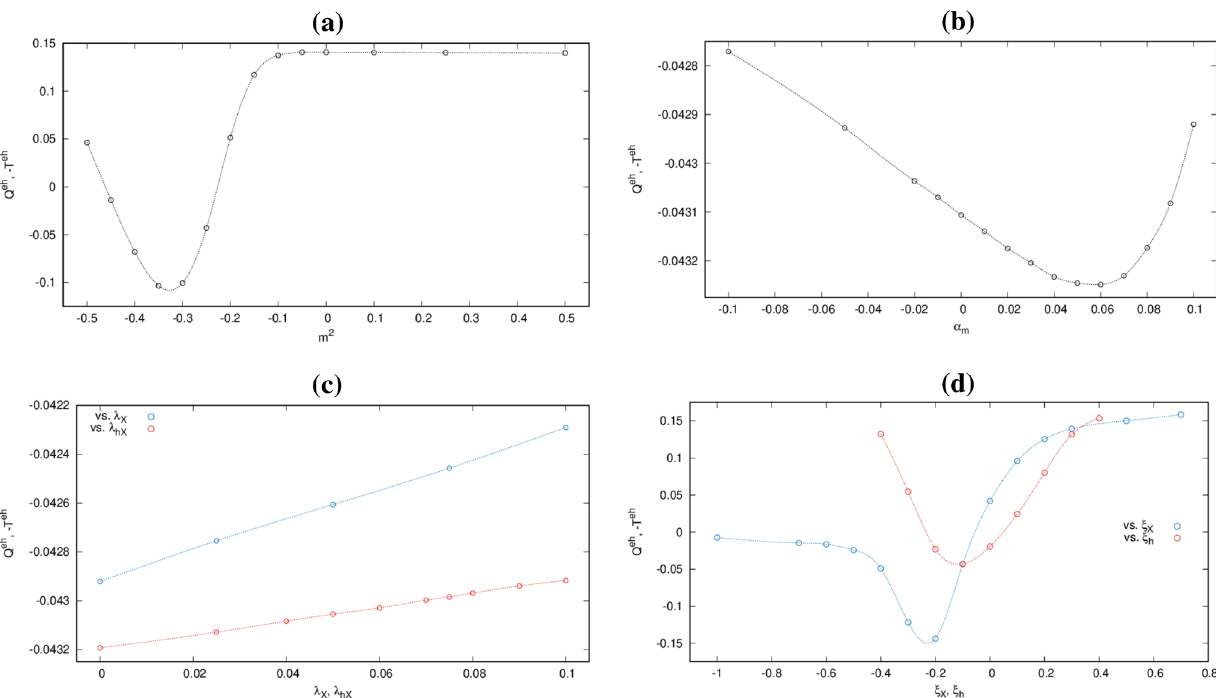
Fig. 13 The black hole charges related to the U ( 1 ) gauge fields, Q eh and T eh , as functions of a m 2 , b α m , c λ X ,λ hX and d ξ X ,ξ h , for evolutions with non-minimal scalar–gravity couplings and non-varying parameters as in Fig. 11